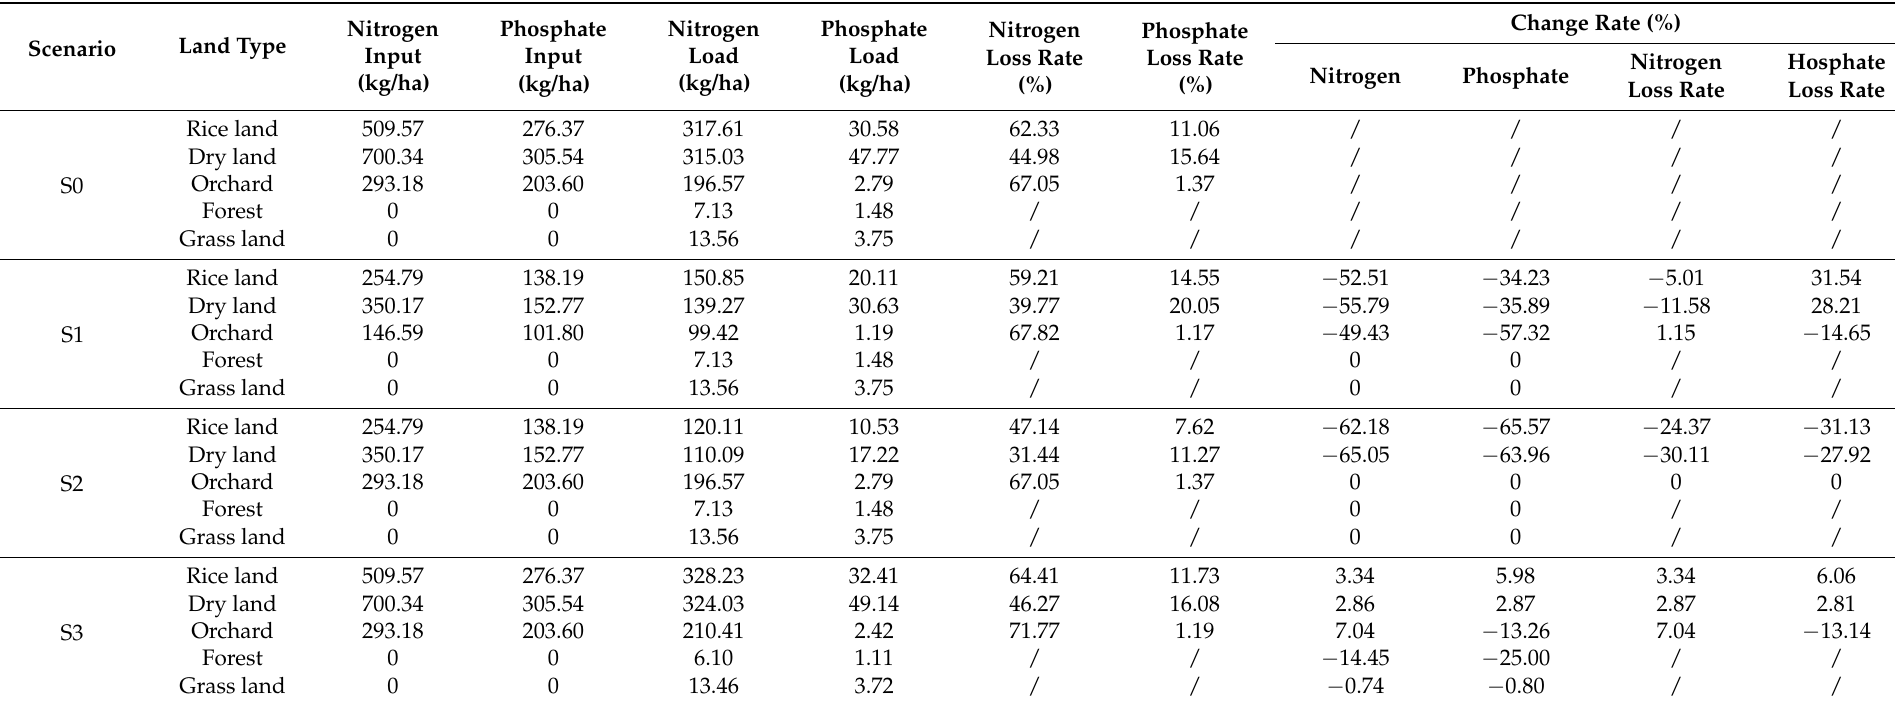
Table 6. Nutrient input and loss per unit area in different scenarios. S0: current situation; S1: halving fertilization every year; S2: fallow every other year; S3: returning agricultural land to